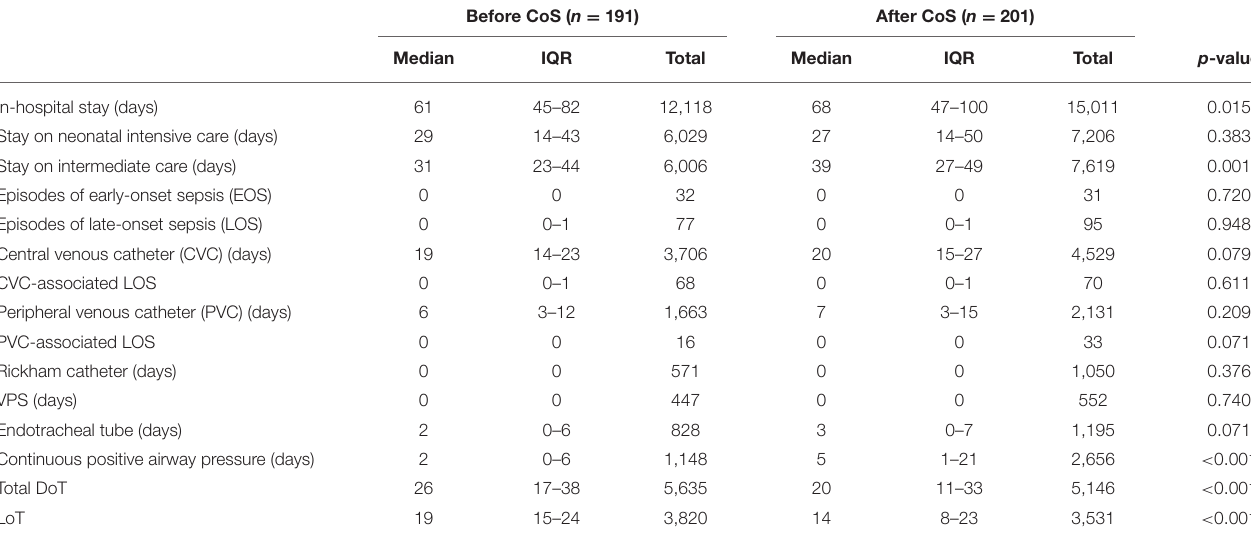
TABLE 4 | Comparison of nosocomial infections, use of devices, length of therapy (LoT), and total days of therapy (DoT) between the two cohorts before and after the introduction of colonization screening